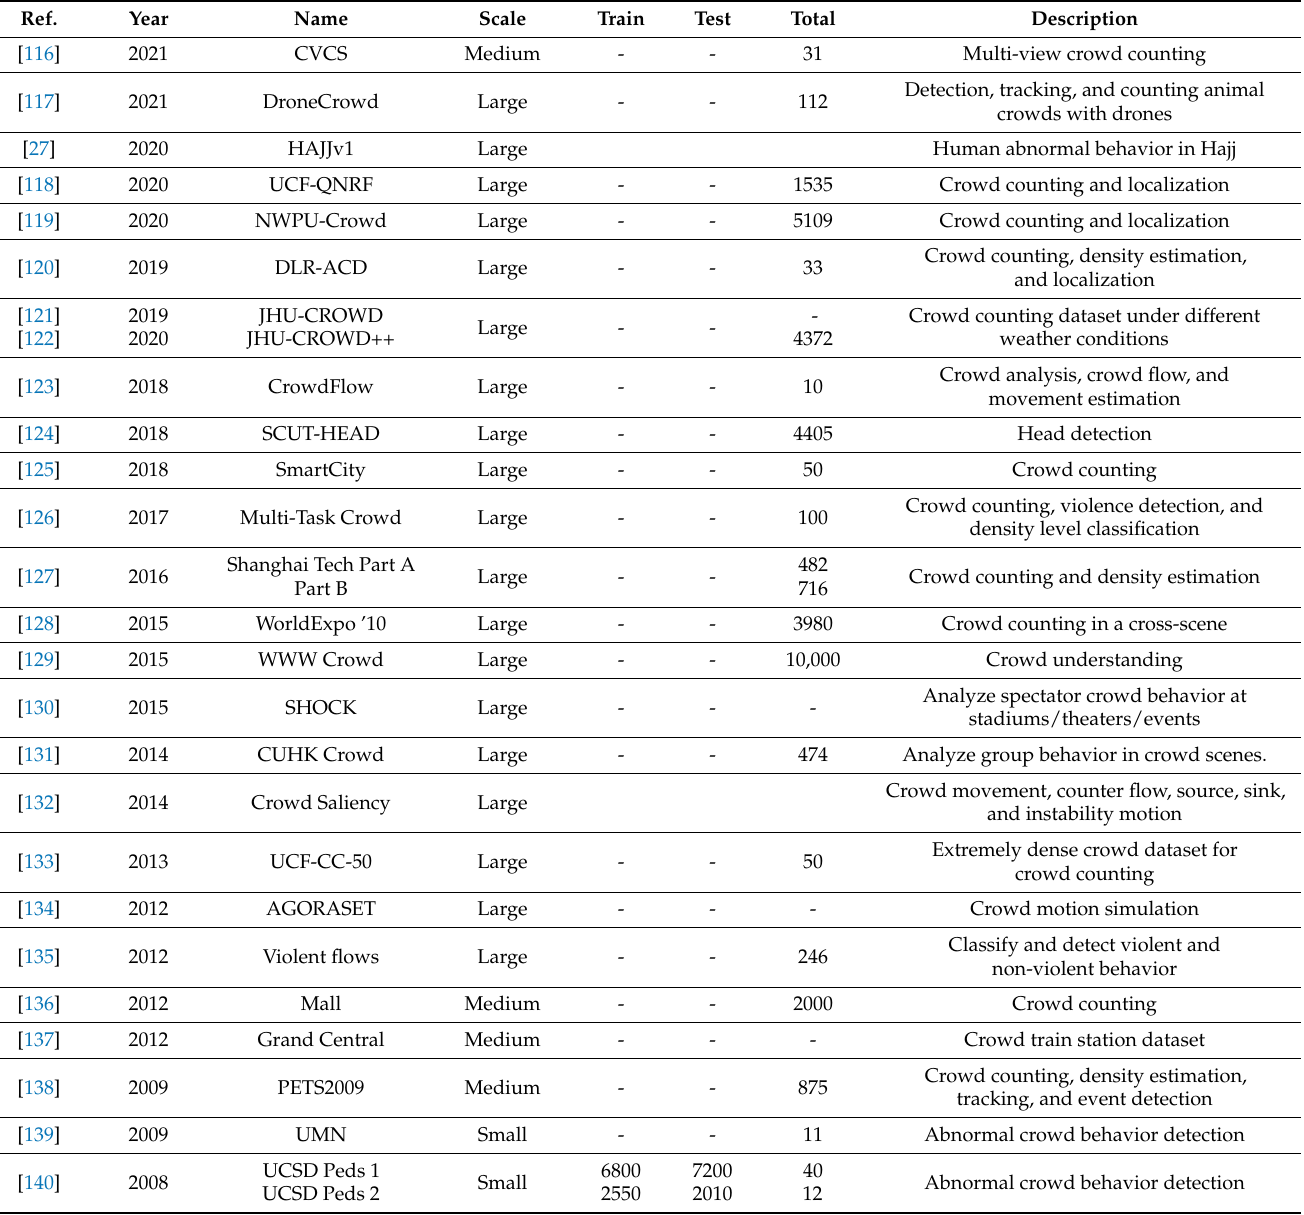
Table 3. Summary of available crowd datasets.